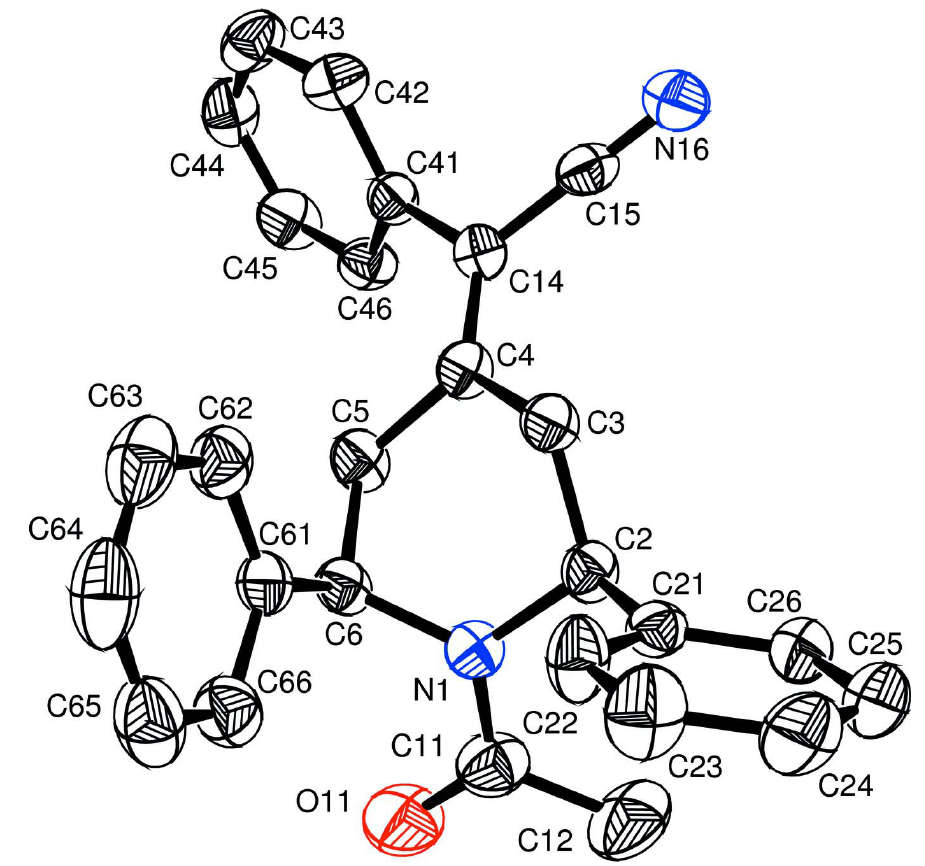
The molecular structure of the title compound, showing the atom-numbering scheme and displacement ellipsoids drawn at the 50% probability level. H atoms have been omitted for